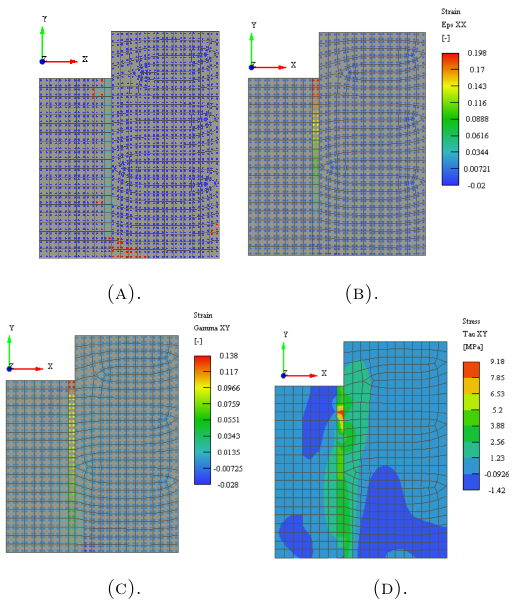
Figure 12. ASTM shear test simulation result at (A- C) ∆ x,DIC = 0 . 3 mm and (D) ∆ x,DIC = 0 . 16 mm for intermediate parameters from Table 2 and δ m,crit = 0 . 055 mm: (A) crack parallel to the grain (red) and non-linear deformation zone (green) developed under compression and shear stress states, (B) normal strain ε xx , (C) shear strain γ xy , and (D) shear stress τ xy